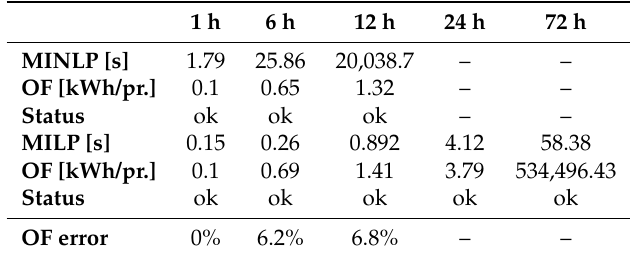
Table 1. Performance of the MINLP and